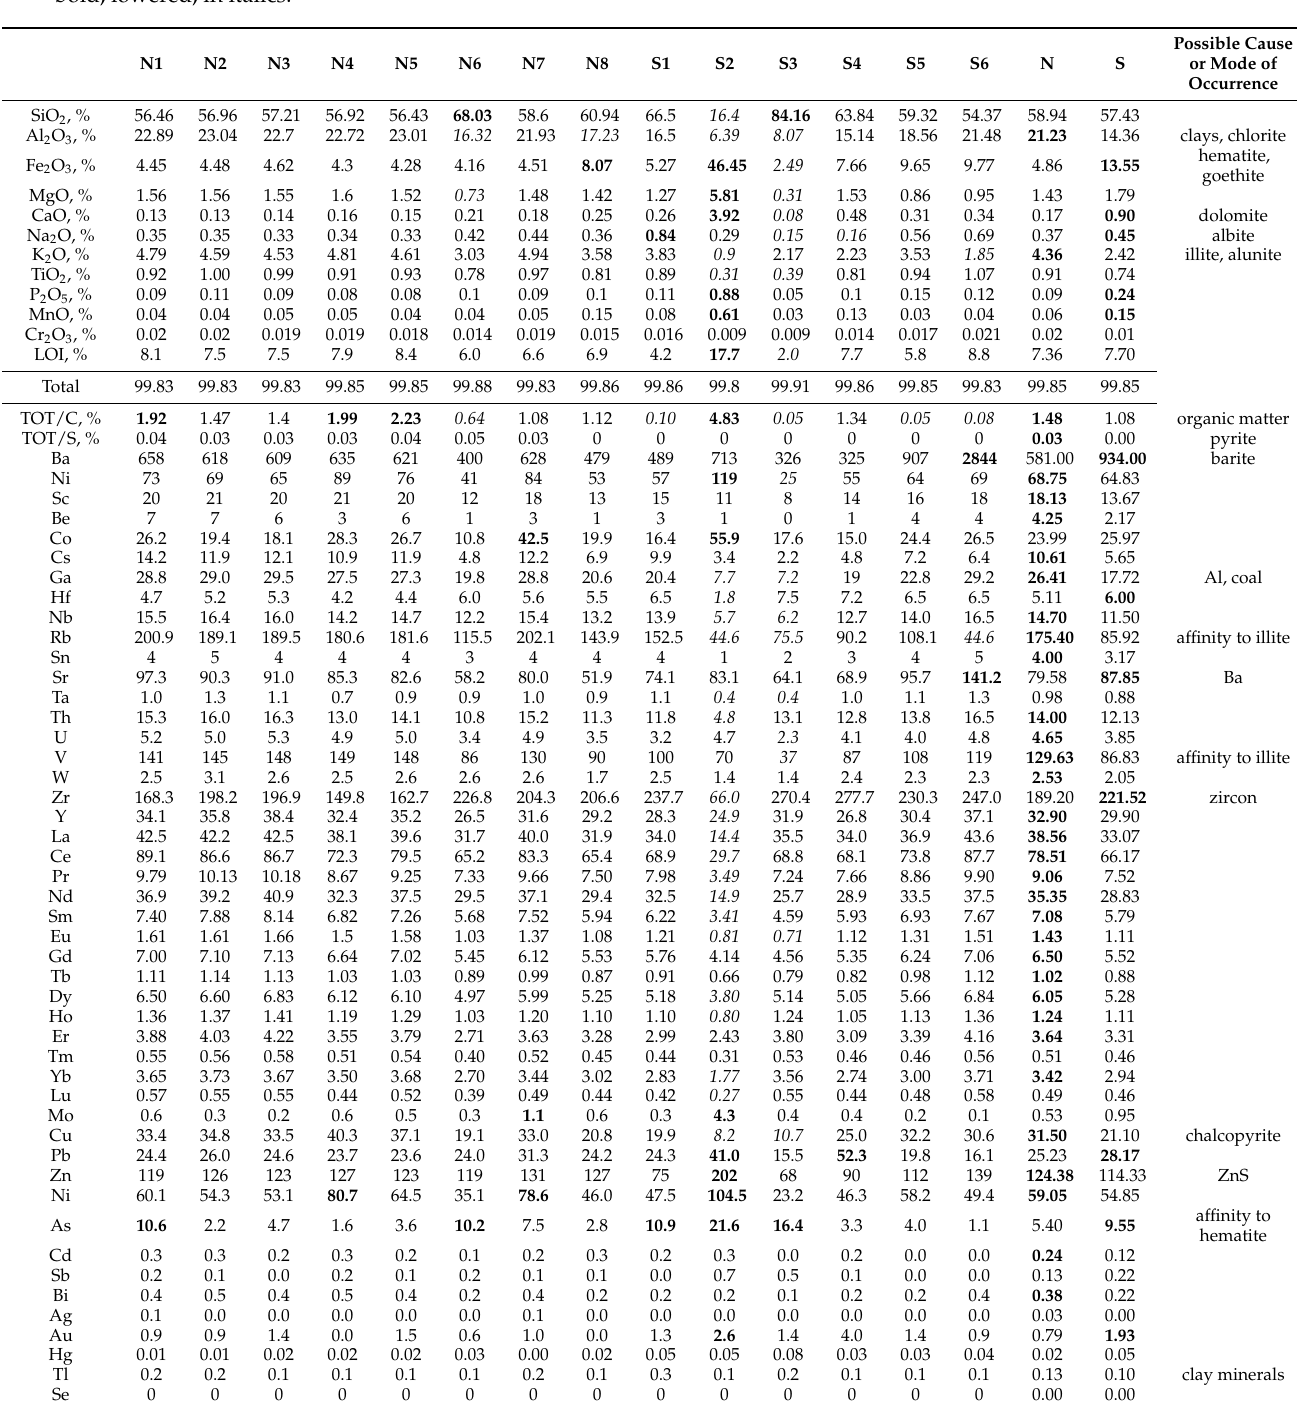
Table 3. Chemical composition of the gangue-rocks samples from the northern (N1–N8) and southern (S1–S6) parts of the Jas-Mos mining area (in ppm, except where otherwise indicated) with averaged N and S. Increased values are marked in bold, lowered, in